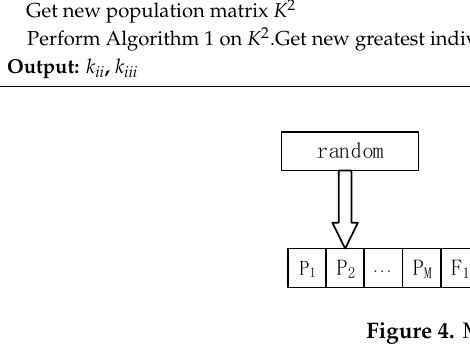
Figure 3. Crossover operation.